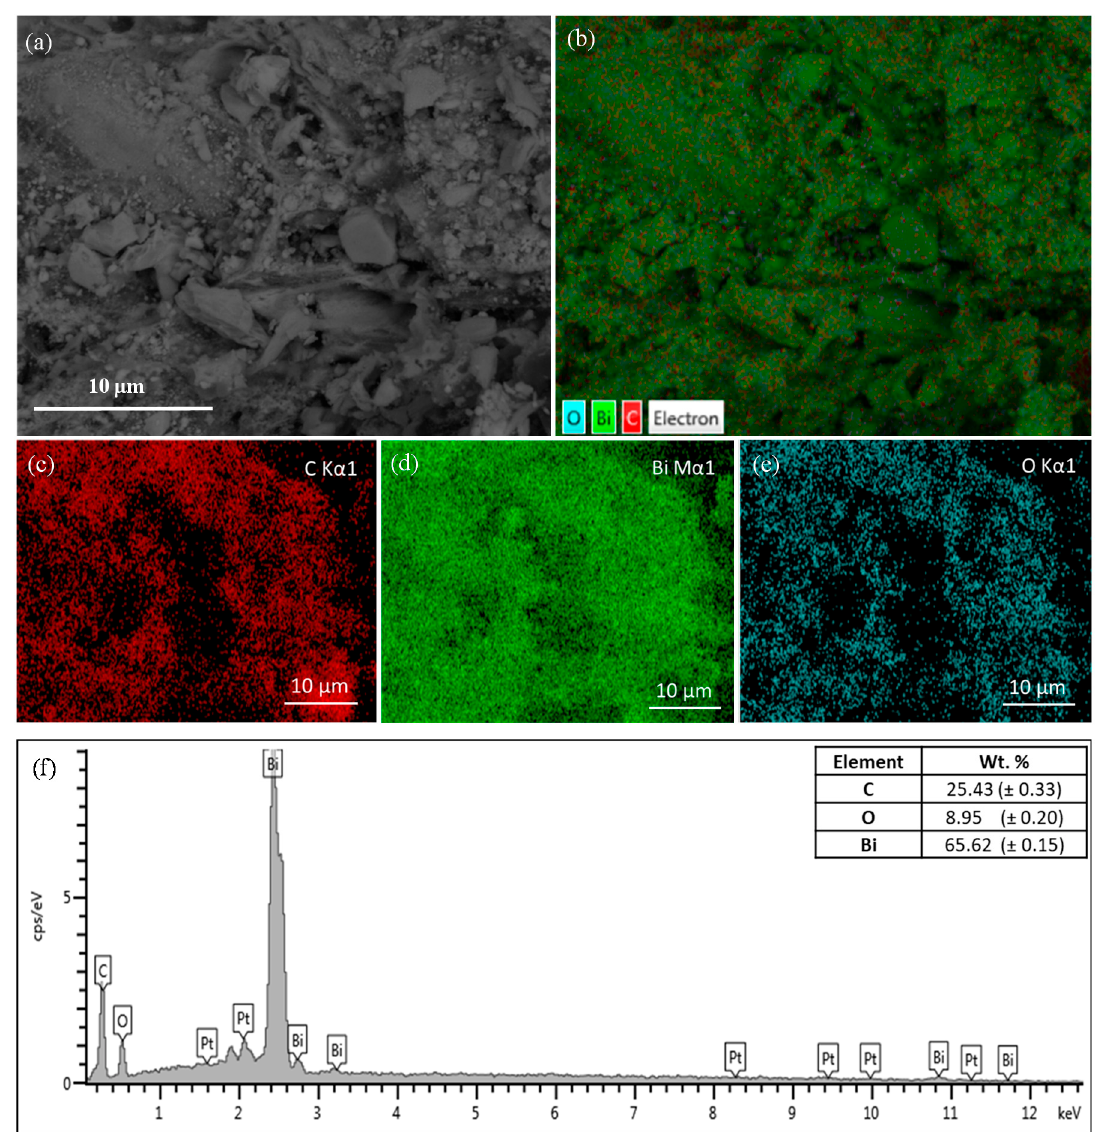
Figure 2. Biochar–BiO x composite elemental analysis by EDS ( a ) targeted surface, ( b – e ) mapping and ( f ) scanning.